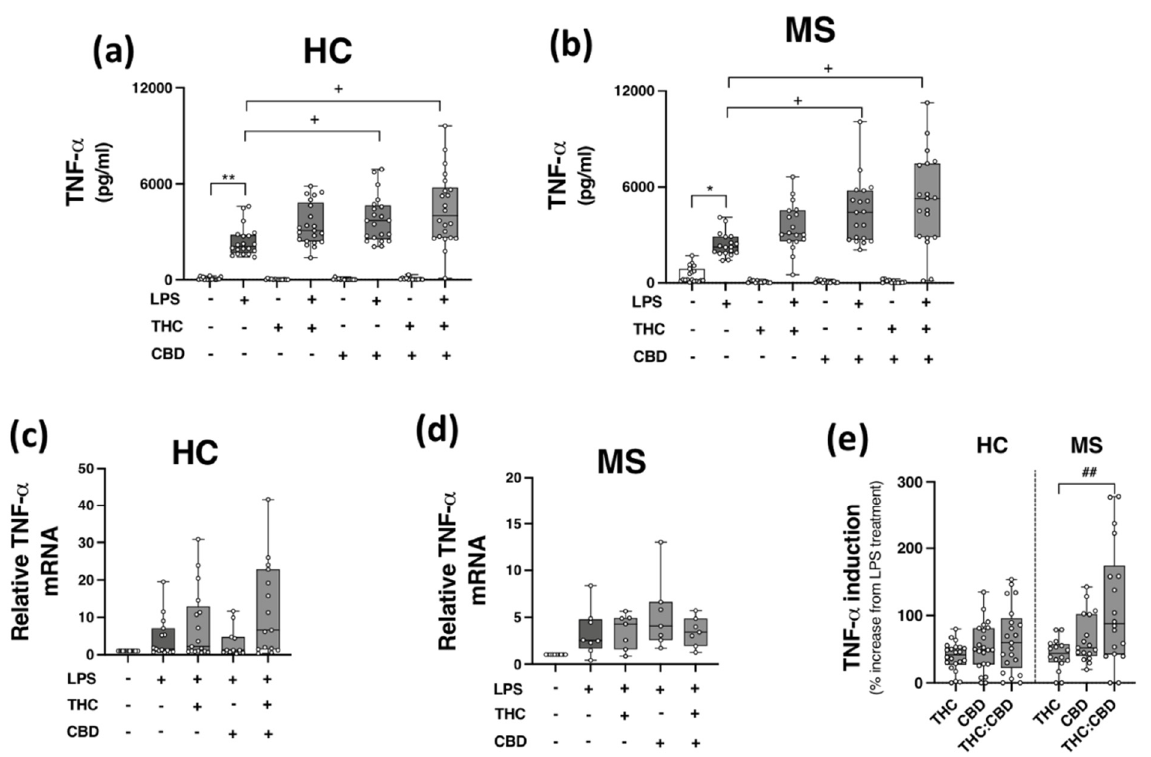
Figure 4. CBD and THC:CBD exacerbate TLR4-induced TNF- α expression in PBMCs from HC subjects and pwMS. Treatment of PBMCs from ( a ) HCs, and ( b ) pwMS with LPS (100 ng/mL; 24